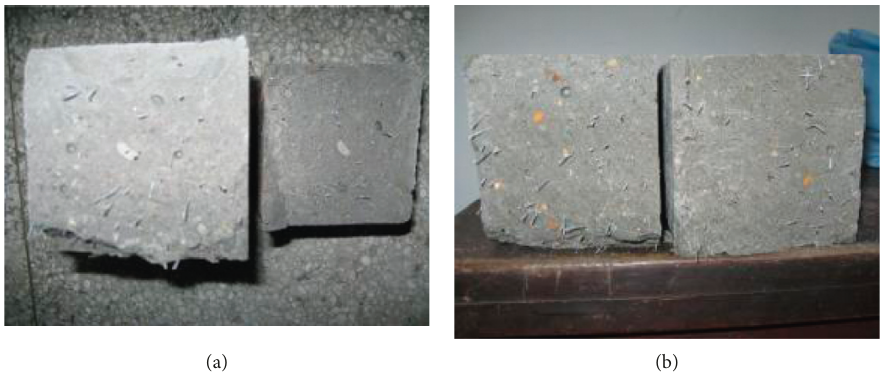
Figure 5: Section of steel fiber-reinforced silica fume concrete.